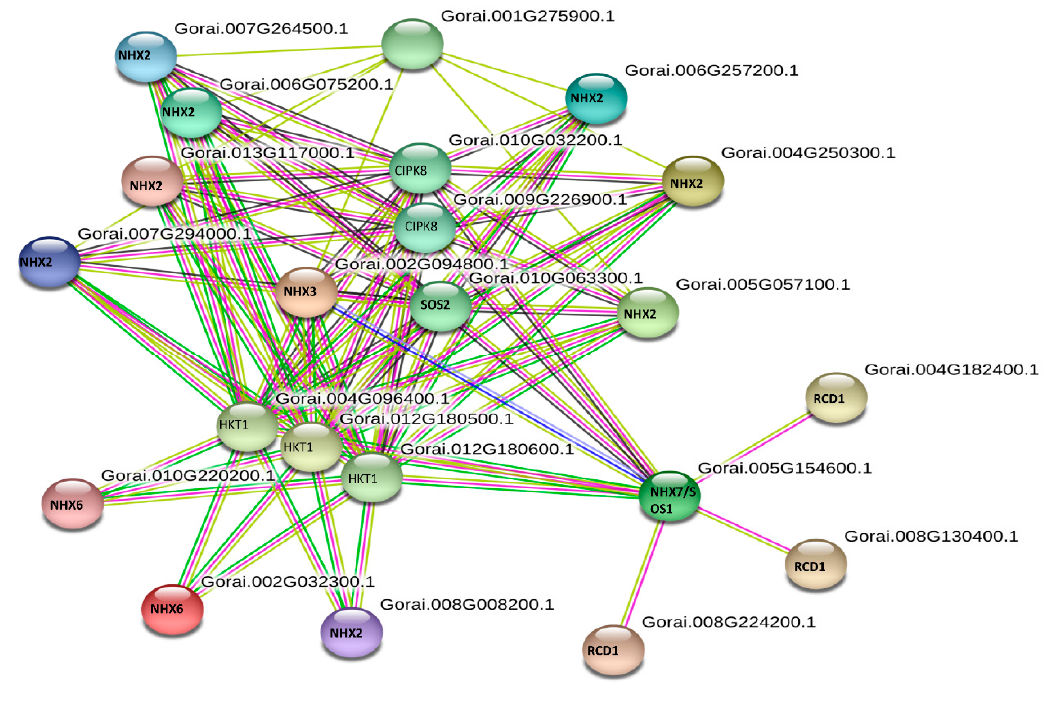
Figure 8. String analysis of GbNHX interacting proteins.